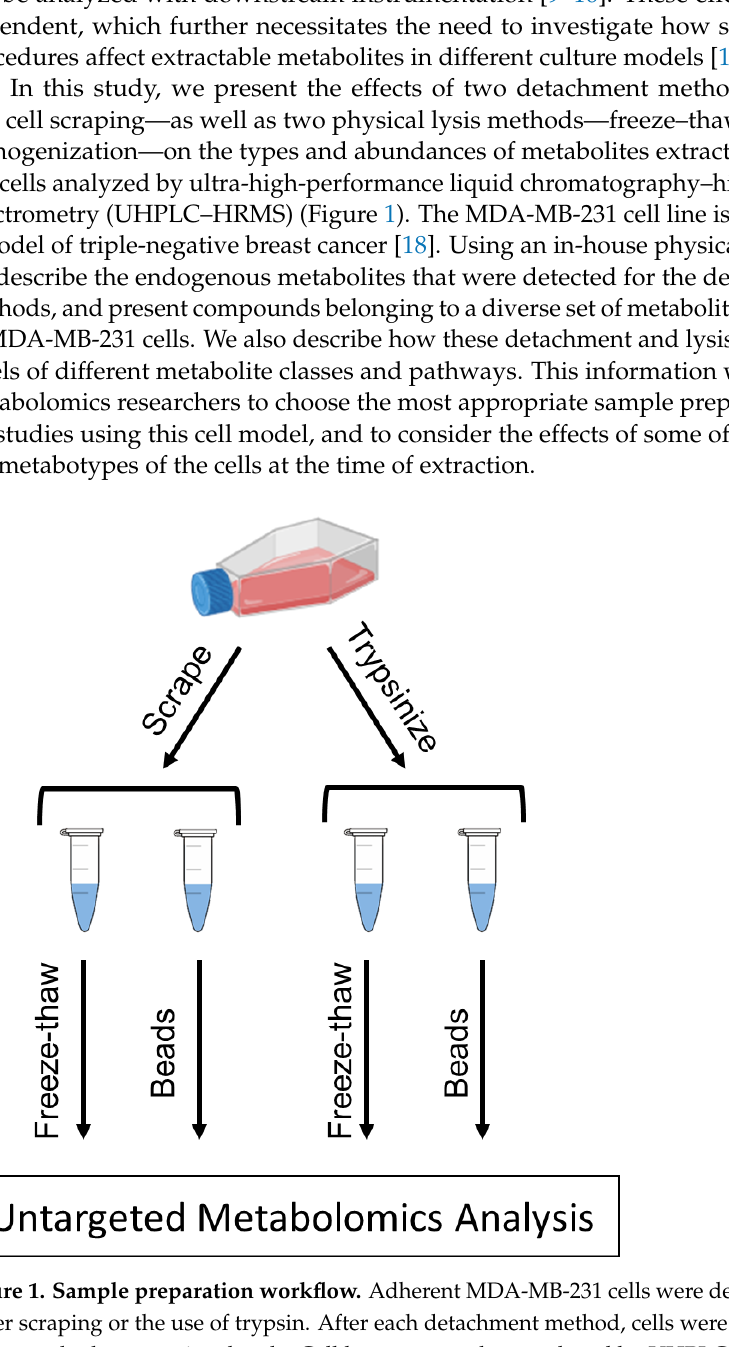
Figure 1. Sample preparation workflow. Adherent MDA-MB-231 cells were detached from flasks by either scraping or the use of trypsin. After each detachment method, cells were lysed by freeze–thaw cycling or by homogenizer beads. Cell lysates were then analyzed by UHPLC–HRMS to determine differences in metabolite abundances between the different methods.